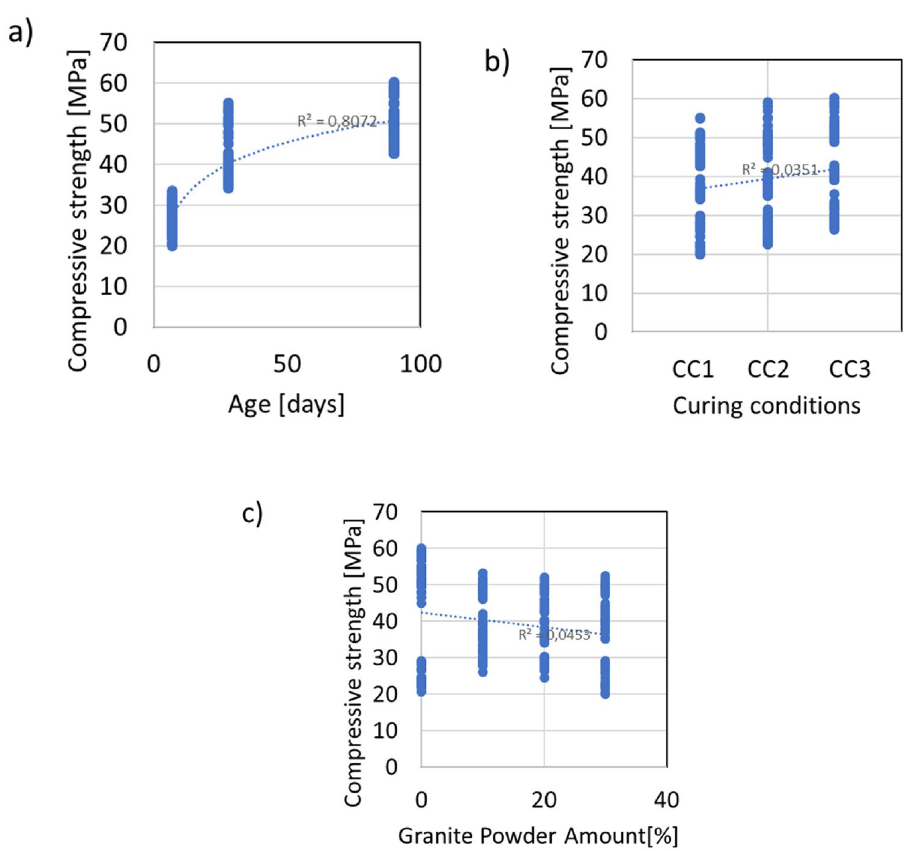
Figure 3. The relations between the compressive strength and ( a ) age, ( b ) curing conditions and ( c ) granite powder